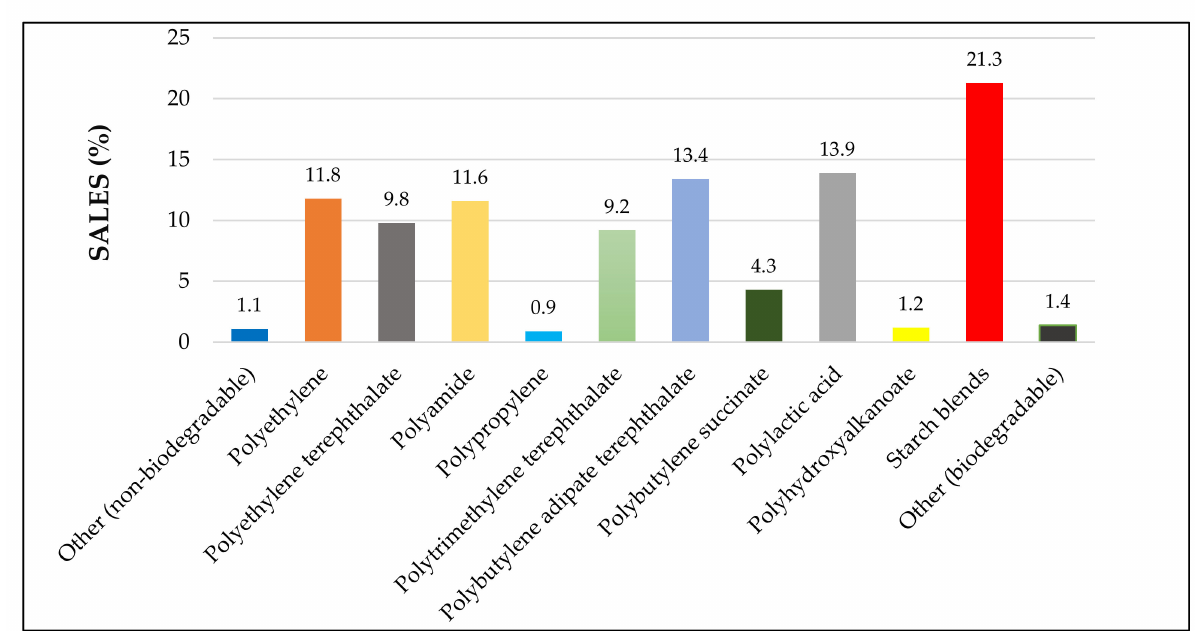
Figure 1. Global production capacity of different materials in 2019 (Adapted from European bioplastic data—2019